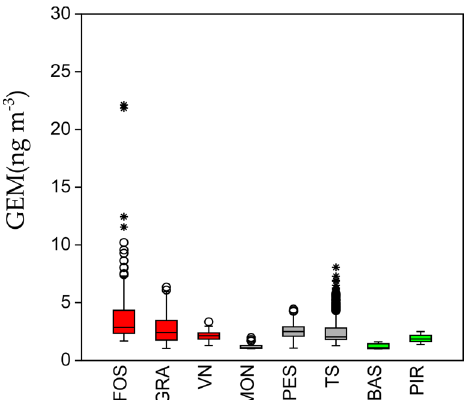
Figure 2. Boxplots of GEM observed in the investigated sites. ( red ) Hg-contaminated sites; ( grey ) urban sites; ( green ) nonurban and pristine sites.